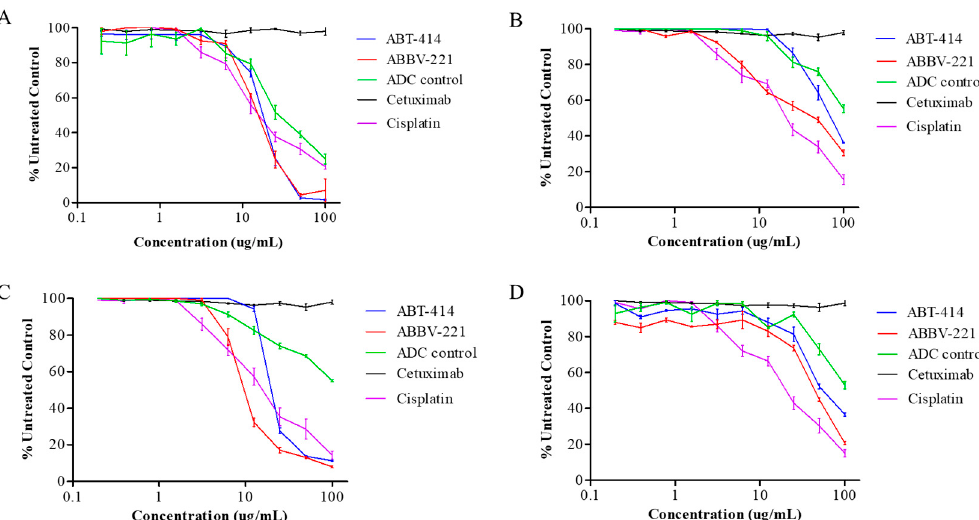
Figure 2. Cell proliferation assays (MTS). Cell proliferation ratio (% untreated control) and the concentration of each drug are indicated on the vertical and horizontal axes. Inhibition of cell proliferation in ( A ) MSTO-211H, ( B ) NCIH-28, ( C ) NCIH-2052 and ( D ) NCIH-2452 treated with different concentrations of ABT-414 (in blue), ABBV-221 (in red), antibody drug conjugate-microtubule inhibitor, monomethyl auristatin F (ADC-MMAF) control (in green), cetuximab (black) and cisplatin (purple) measured at day 7 of growth.